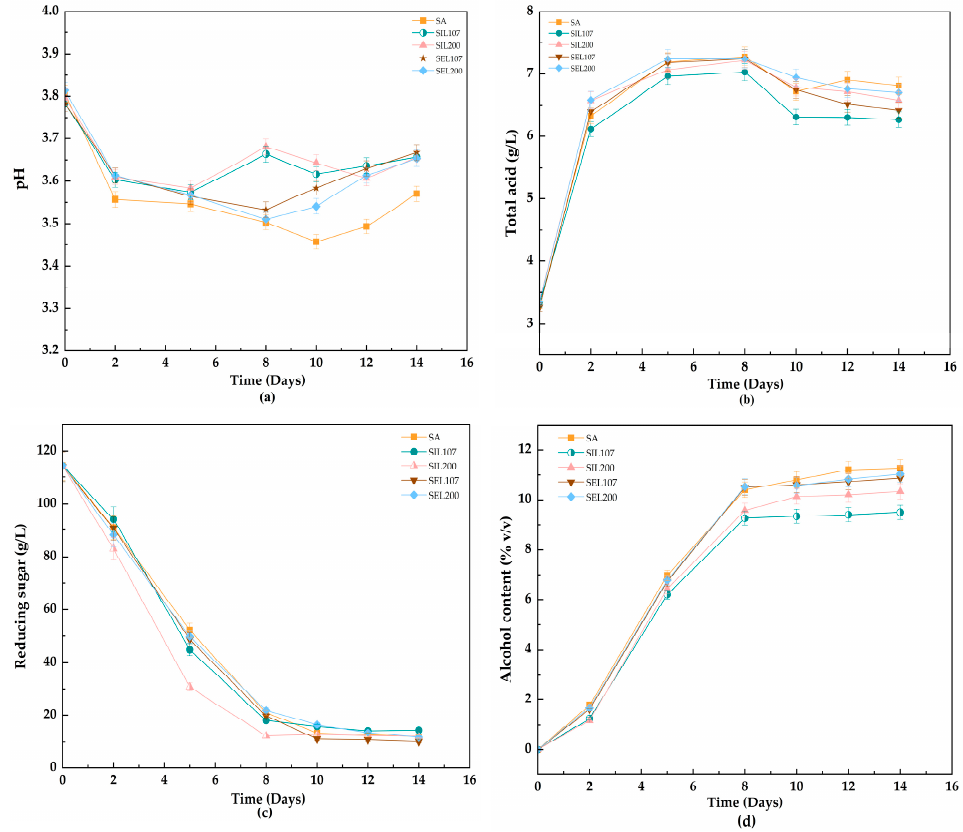
Figure 1. Dynamic changes of pH ( a ), total acids ( b ), reducing sugars ( c ), and alcohol contents ( d ) during apple cider